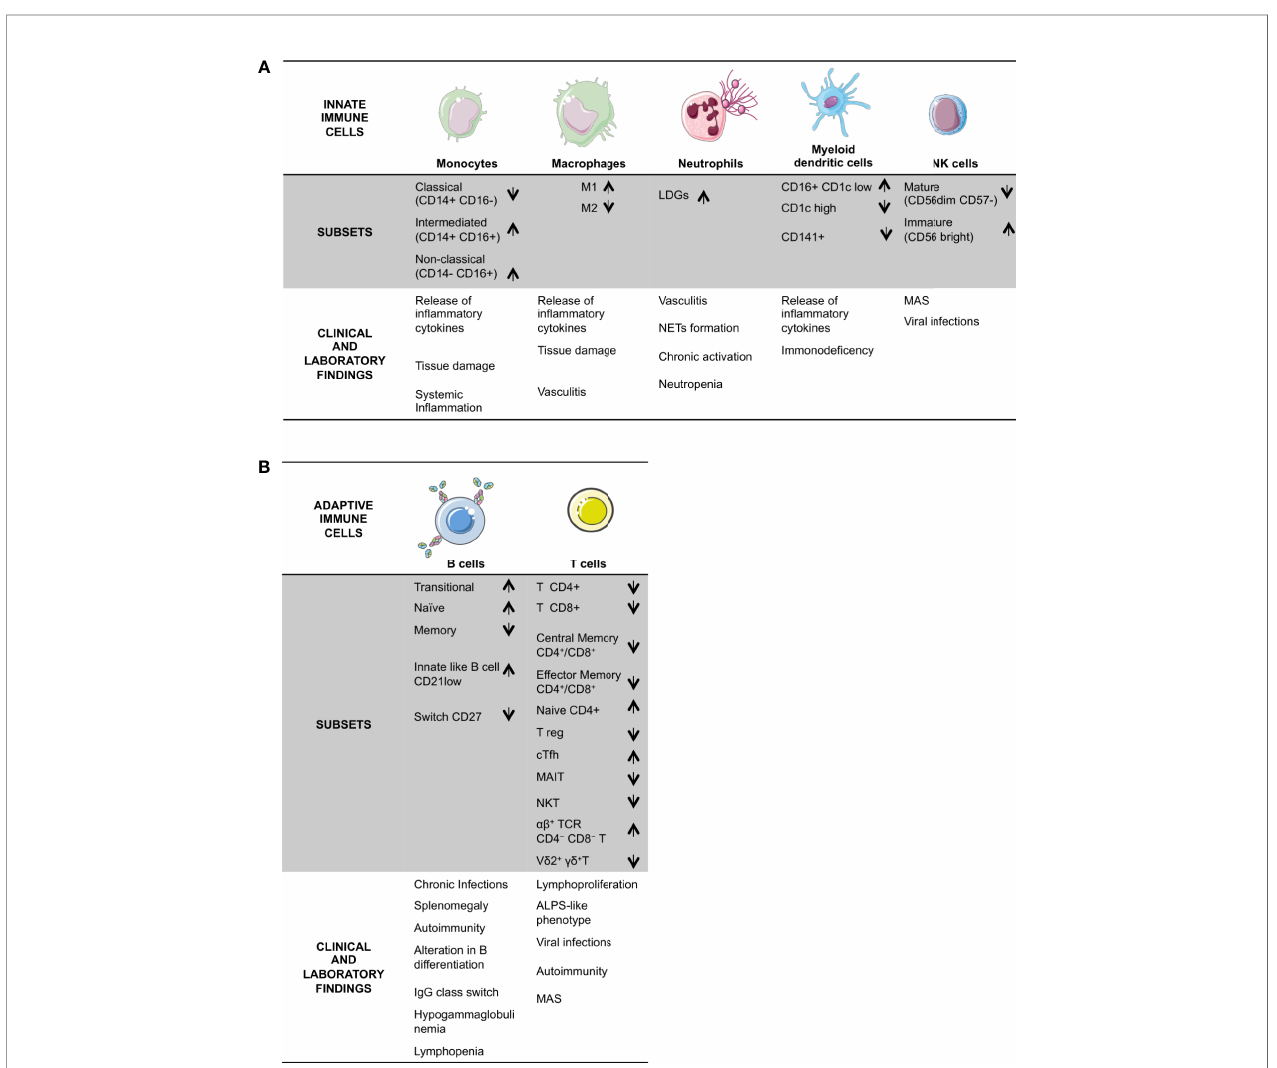
FIGURE 1 | Schematic overview of DADA2 alterations in immune cells and the described related clinical signs and laboratory fi ndings. DADA2 is associated with a wide variety of clinical manifestations. Here is a summary of clinical and immunological features, grouped in the two branches of the immune system; innate (A) and adaptive (B) . LDG, Low Density Granulocytes; Treg, regulatory T cells; cTfh, circulating Tfh; MAIT, mucosal-associated invariant T; MAS, macrophage activation syndrome; ALPS; Autoimmune Lymphoproliferative